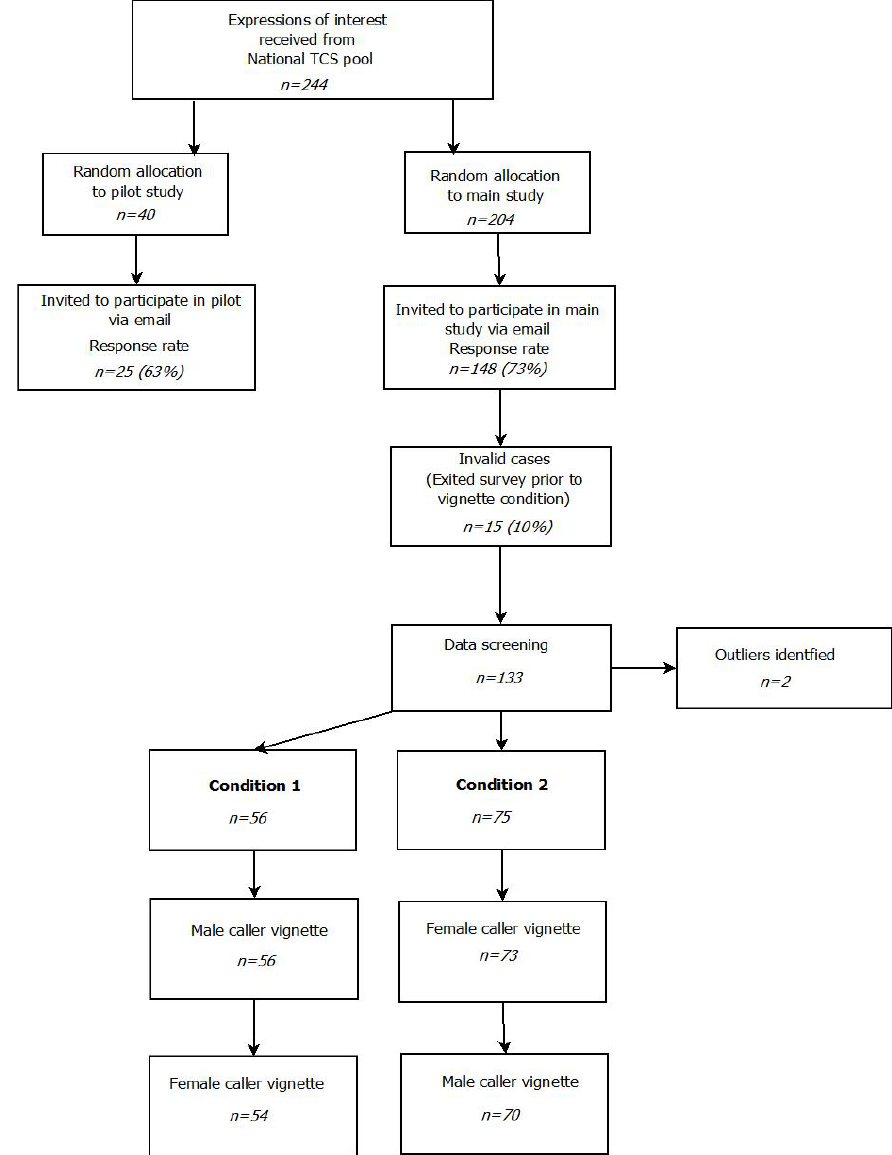
Figure 2. Recruitment flow diagram for pilot and main study.